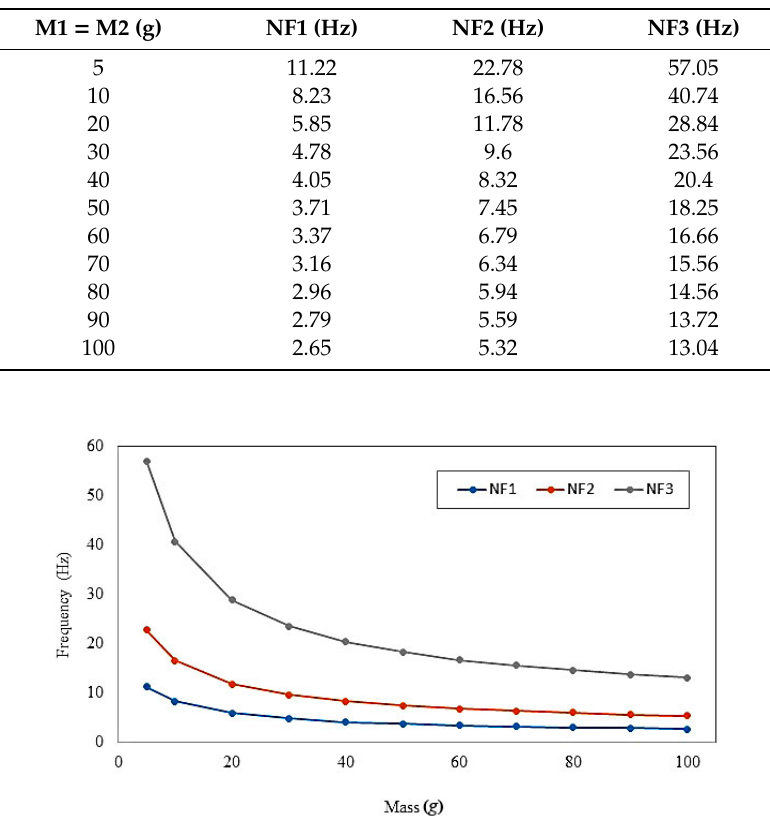
Figure 2. First three natural frequencies of the branched cantilever beam with varying masses obtained from ANSYS modal analysis (NF: natural frequency).